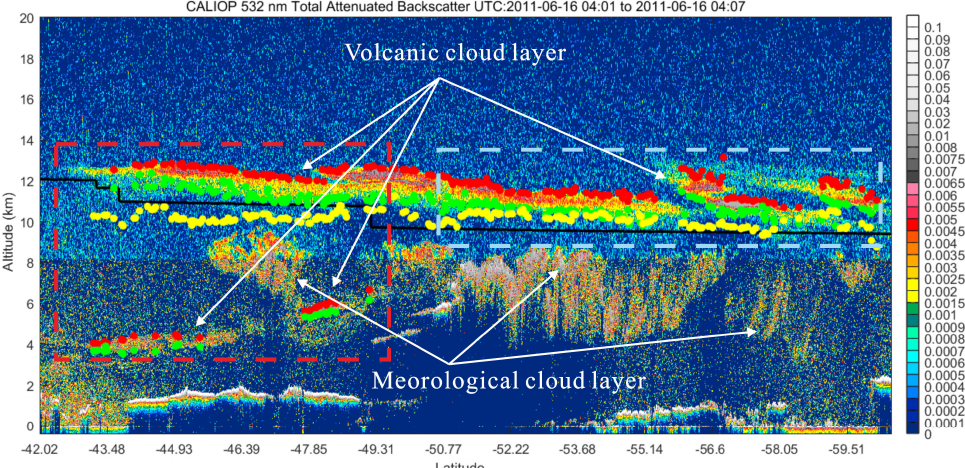
Figure 12. CALIOP 532 nm total-attenuation backscattering profile for 04:01–04:07 UTC, 16 June 2011, for the Puyehue–Cord ó n Caulle eruption. The solid black line represents the tropopause, the red dot is the CALIOP CTH, the green dot is the CALIOP CBH, and the yellow dot is the VBH predicted by PCA_GBDT; the red dashed box represents multi-layer volcanic ash cloud; the blue dashed box represents single-layer volcanic ash cloud [15].